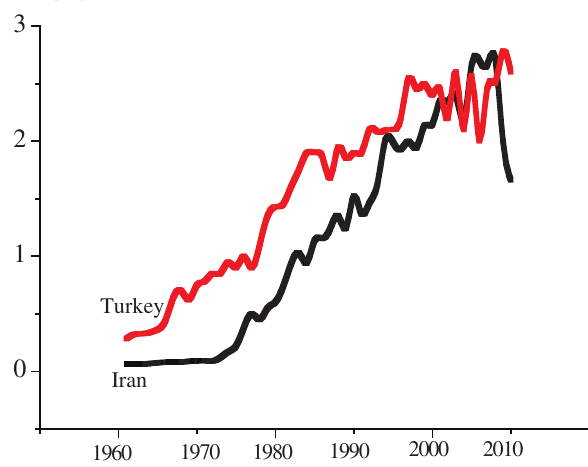
Fig. 3. Apple production of Iran and